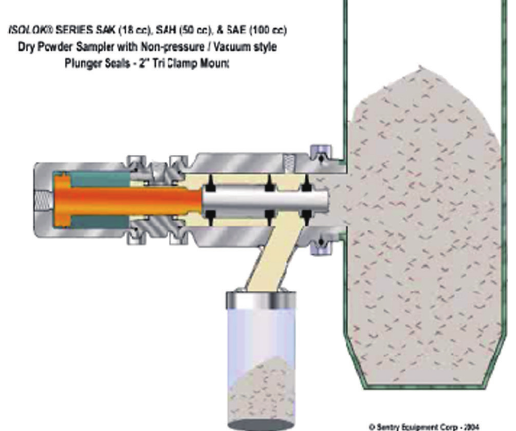
Fig. 6 Schematic of a Screw Sampler. (Courtesy of Sentry Equipment,